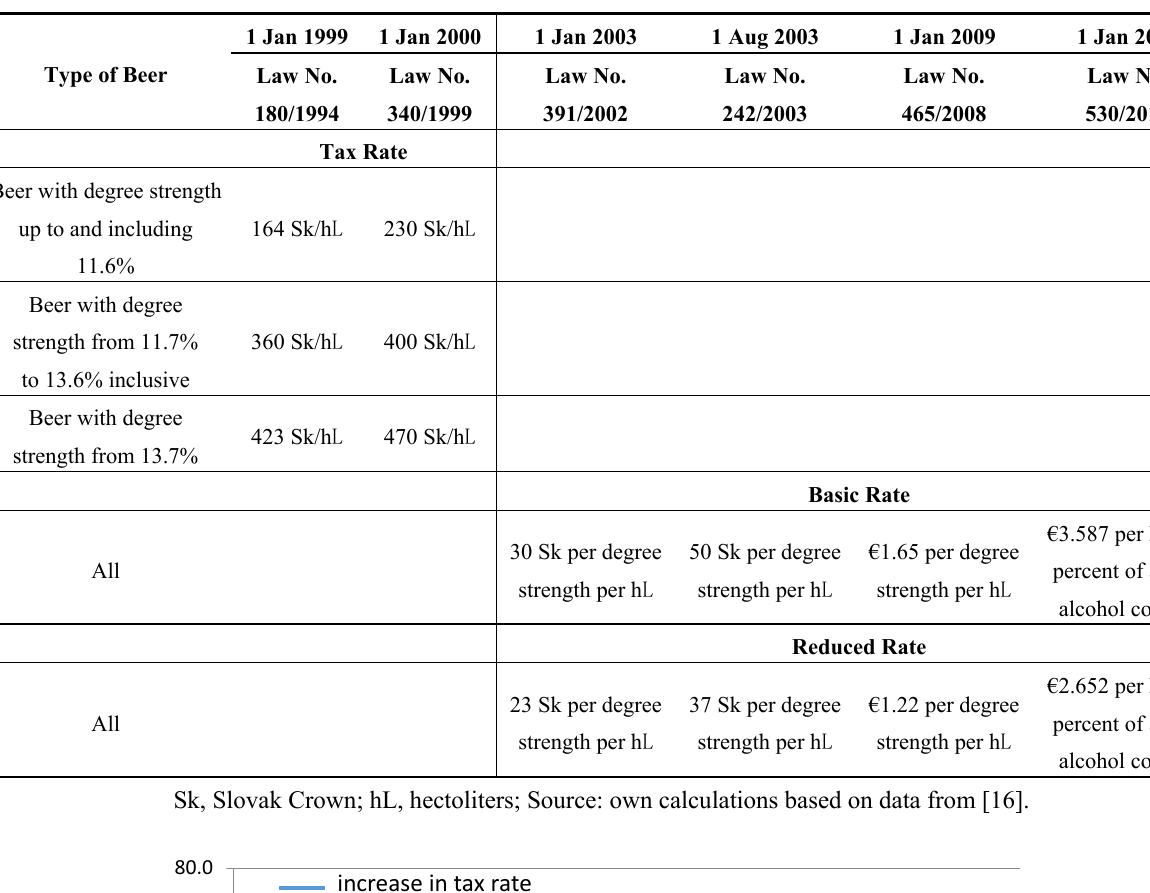
Table 2. Overview of the development of the tax rate on beer.